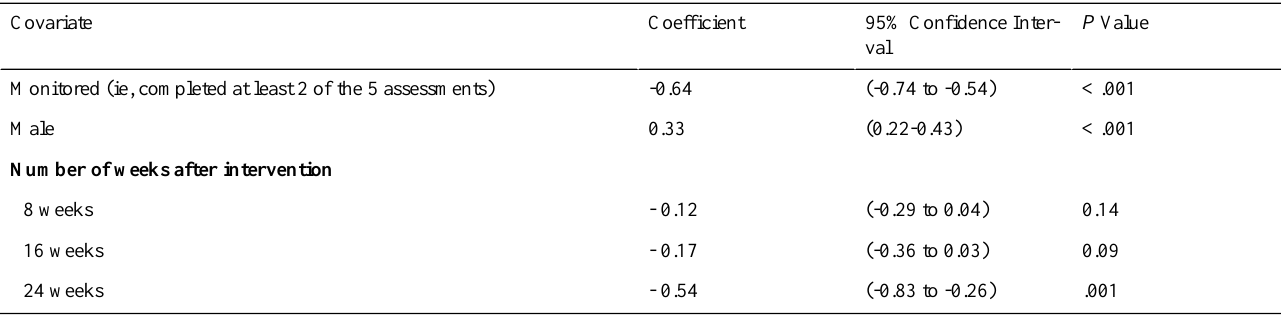
0.14(-0.29 to 0.04)- 0.128 weeks 0.09(-0.36 to 0.03)- 0.1716